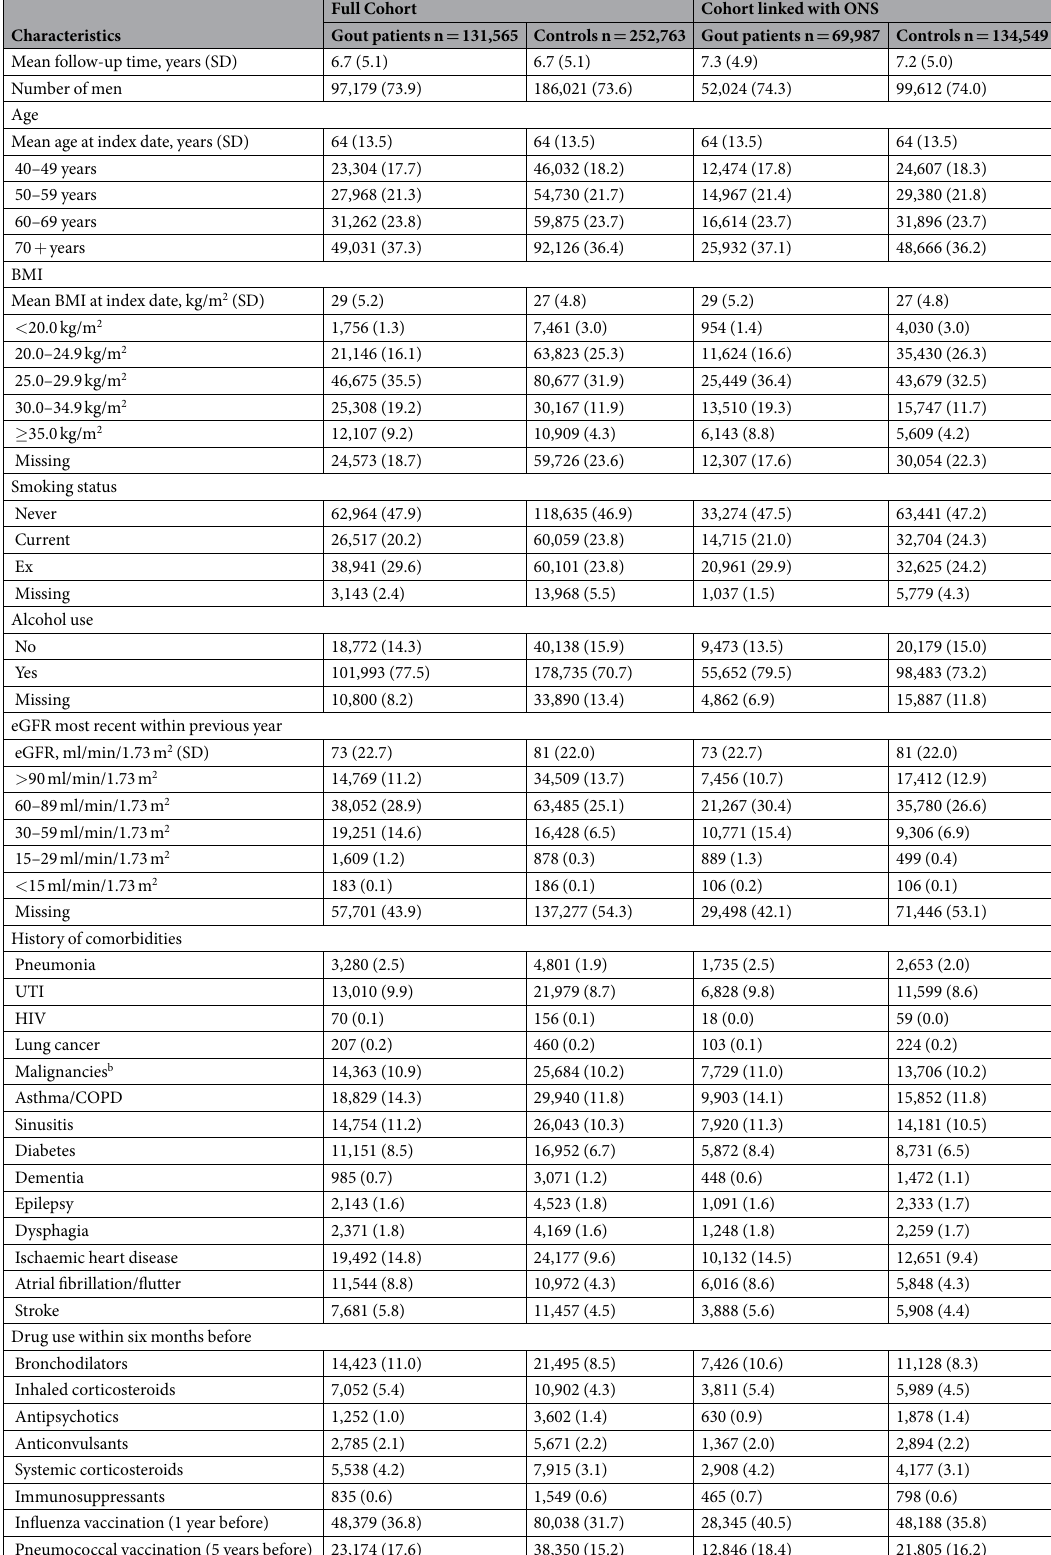
Table 1. Baseline characteristics of patients with gout and controls, separately for the full sample and the sample that could be linked to death certificate data from the Office of National Statistics (ONS) a . Abbreviations: SD, standard deviation; ONS, the Office of National Statistics; BMI, Body mass index; eGFR, estimated Glomerular Filtration Rate; HIV, Human Immunodeficiency Virus; COPD, Chronic Obstructive Pulmonary Disease. a) Data represent the number (%) of patients, unless stated otherwise. b) Excluding non-melanoma skin